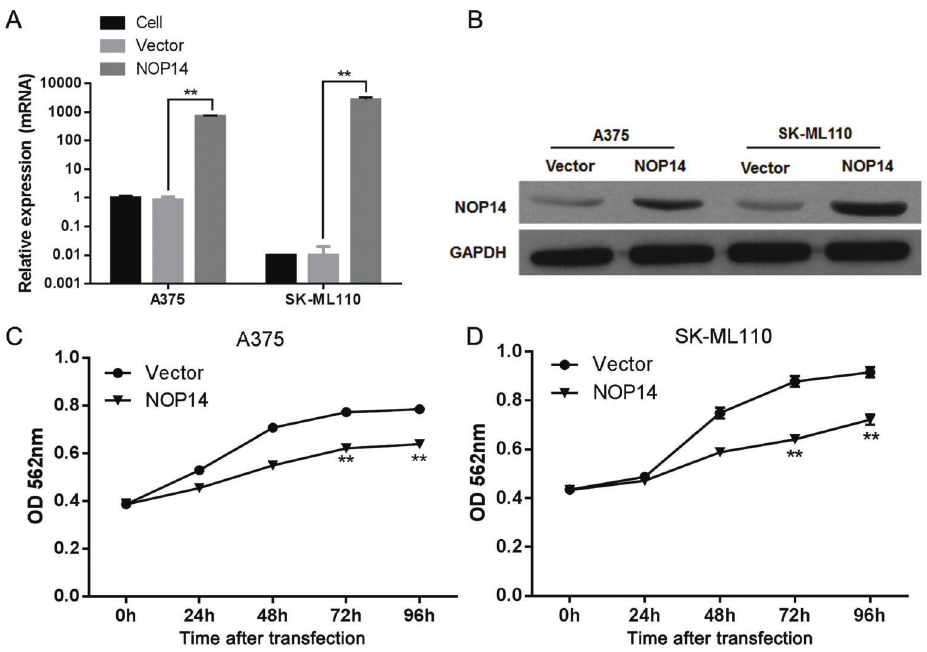
Figure 2. Effect of nucleolar protein 14 (NOP14) overexpression on melanoma cell proliferation. NOP14 mRNA levels ( A ) and protein levels ( B ) in melanoma cell lines transfected with NOP14 overexpression and empty vectors. C and D , Cell proliferation analysis of melanoma cells after transfection of NOP14 overexpression and empty vectors. Data are reported as means ± SD. **P o 0.01 vs empty vector